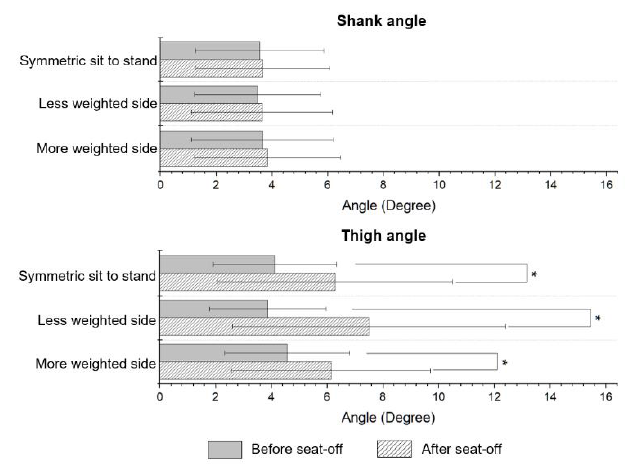
Figure 6. Comparison of RMSEs of segment angle between different STS ranges of shank angle and thigh angle. * indicates significant difference ( p < 0.05).